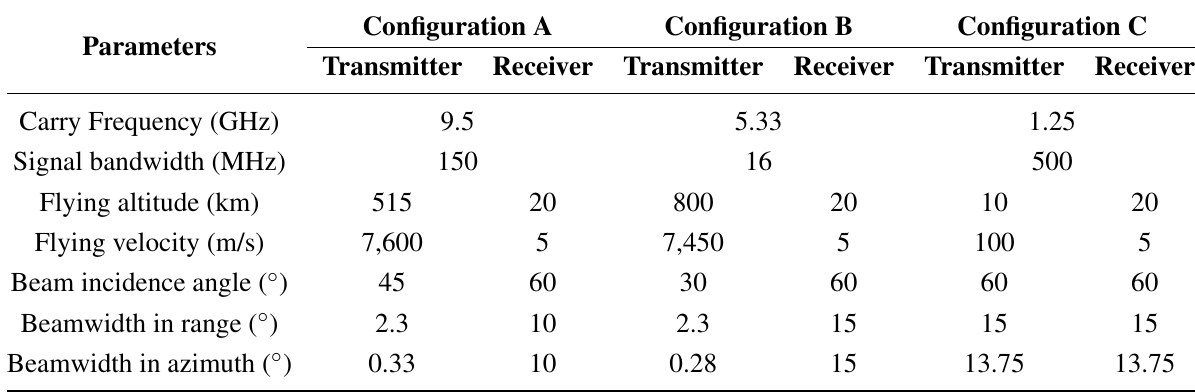
Table 1. Example configuration parameters for the HAP-borne passive BiSAR system.